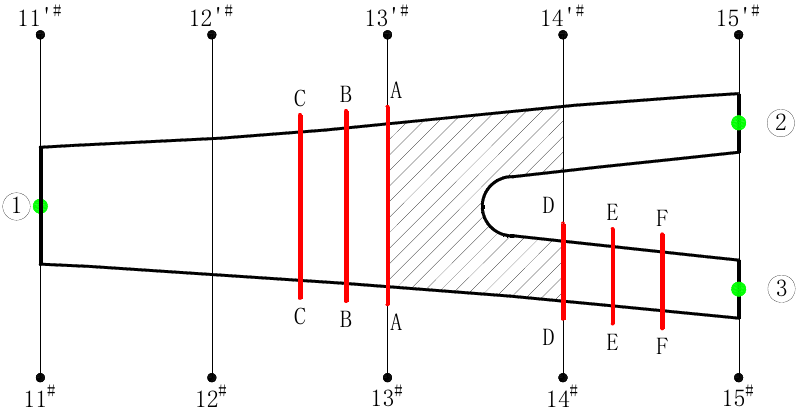
Figure 14. Boundary conditions and analytical sections.